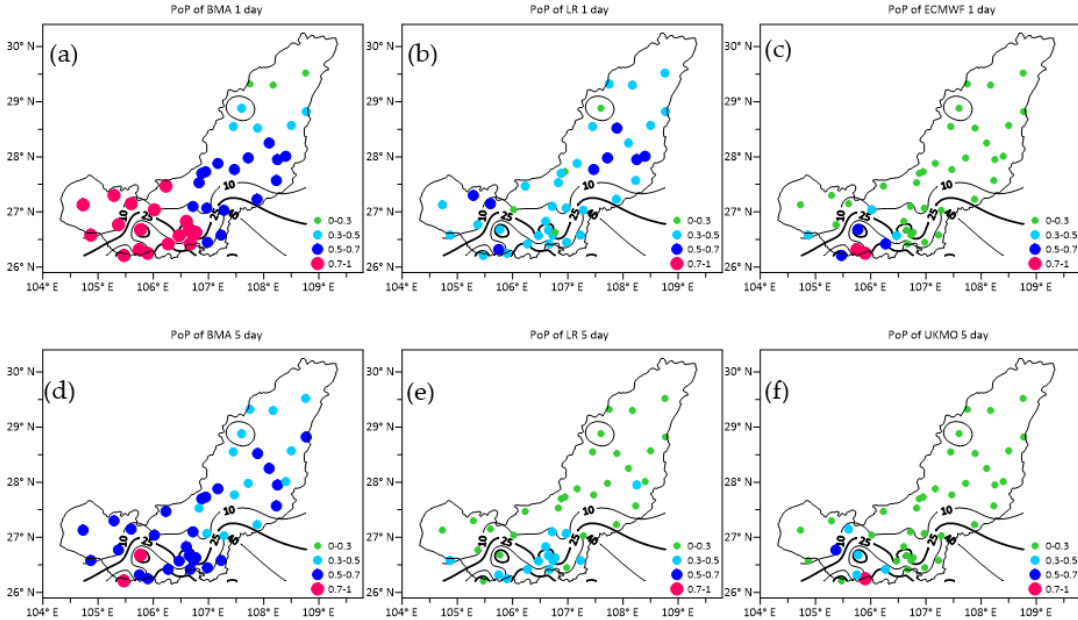
Figure 5. The observed daily precipitation and probability forecasts with precipitation exceeding 25 mm from the BMA ( a , d ), LR ( b , e ), ECMWF ( c ), and UKMO ( f ) with the lead time of 1 day and 5 days on August 7 2018 (the colored dots are forecast probabilities, the black contour is the observed precipitation).